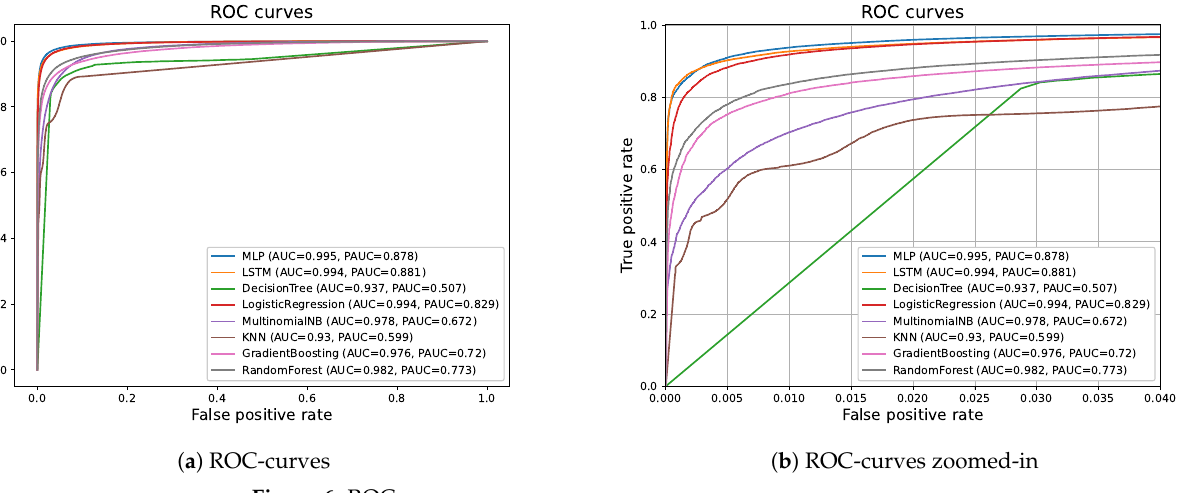
the LR model that both yield 0.994 AUC. The partial AUC (PAUC) for the false positive rate in the range from 0 to 0.04 is 0.881 for the LSTM model, 0.878 for the MLP model, and 0.829 for the LR model.